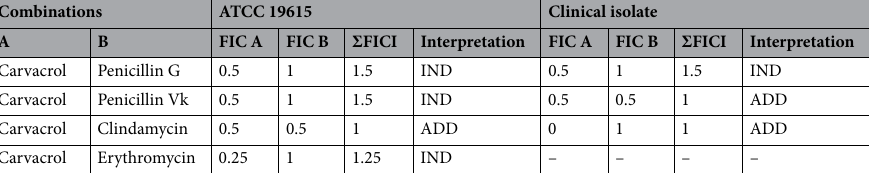
Table 2. The fractional inhibitory concentration (FIC) and FIC index (FICI) for the carvacrol and antibiotic combinations against Streptococcus pyogenes . Fractional inhibitory concentrations (FICs) and fractional inhibitory concentration index (FICIs) were calculated FICI = ΣFIC = FIC A + FIC B where, MIC A value is the MIC of compound A alone, MIC B value is the MIC of compound B alone, and MIC A+B value is the MIC of compound A in the presence of compound B, and vice versa for MIC B+A . FICIs were interpreted as SYN, synergy (FICI ≤ 0.5); ADD, additive synergy (> 0.5 FICI ≤ 1.0); IND, indifference/no interaction (> 1.0 FICI ≥ 4.0); and ANT, antagonism (FICI Index >